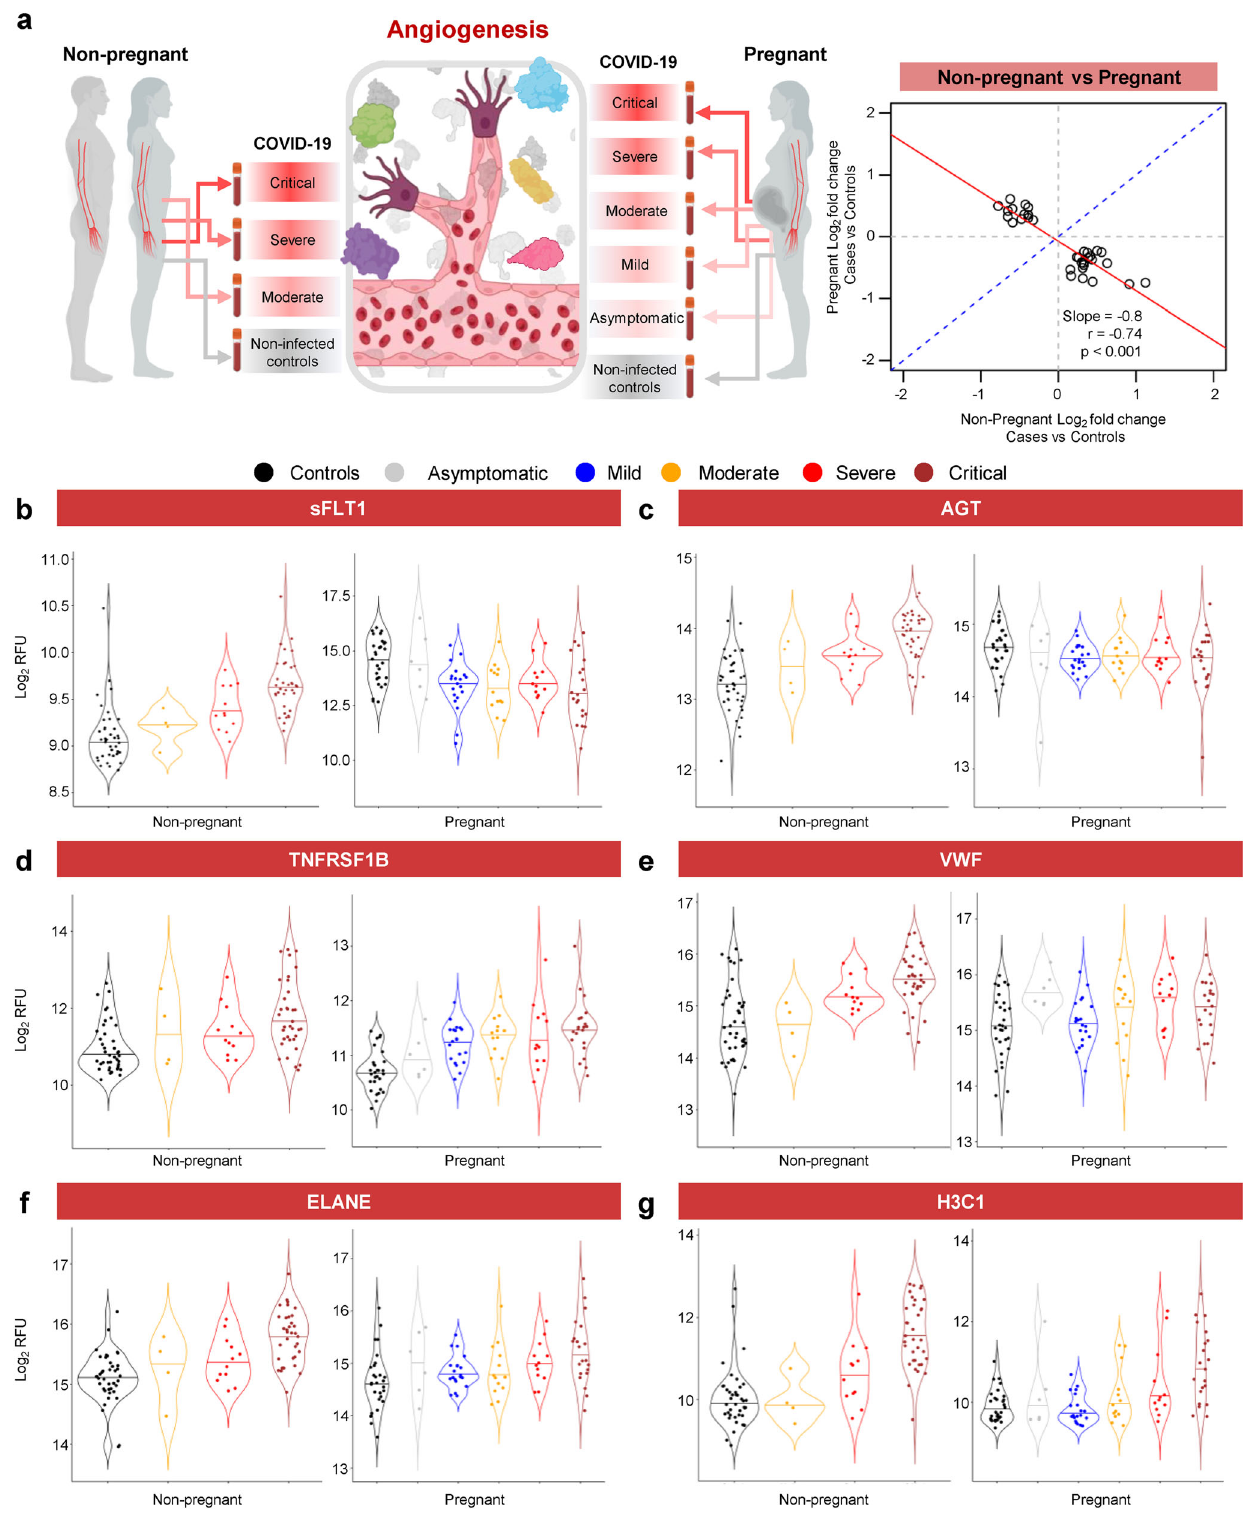
Fig. 6 COVID-19 drives distinct and shared angiogenic and in fl ammatory pro fi les in pregnant and non-pregnant individuals. a Representative diagram illustrating the comparison between pregnant and non-pregnant COVID-19 cases and controls for speci fi c proteins associated with angiogenesis, endothelial dysfunction, and intravascular in fl ammation. A core set of 33 proteins that are signi fi cantly modulated with COVID-19 in opposite directions between pregnant and non-pregnant patients. Note the negative slope and correlation coef fi cient. b – g Violin plots showing the modulation of b sFLT-1, c AGT, d TNFRSF1B, e VWF, f ELANE, and g H3C1 levels with COVID-19 severity in non-pregnant and pregnant cases and controls. Black = control, gray = asymptomatic, blue = mild, yellow = moderate, red = severe, and brown = critical. RFU = relative fl uorescence